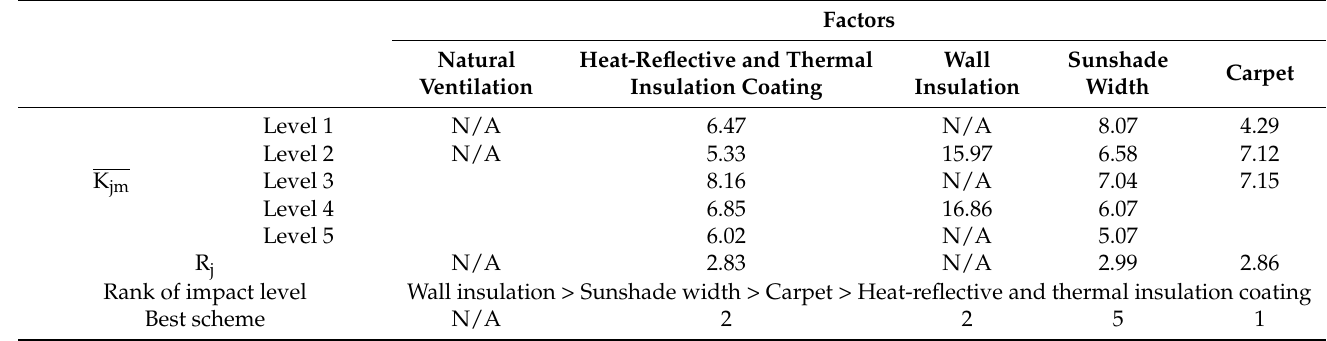
Table 10. Sensitivity analysis of the dynamic investment payback period.